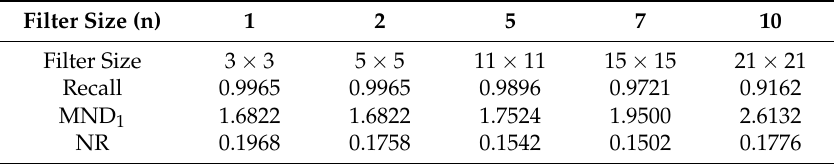
Table 5. Human detection results with diverse size of local searching